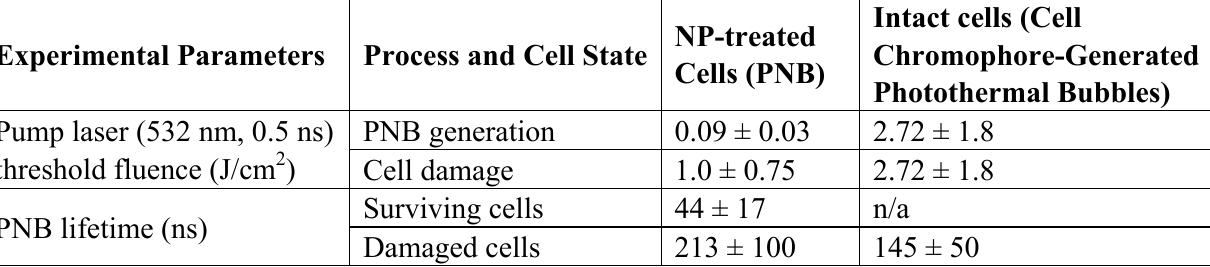
Table 3. Parameters of PNBs and intracellular photothermal bubbles